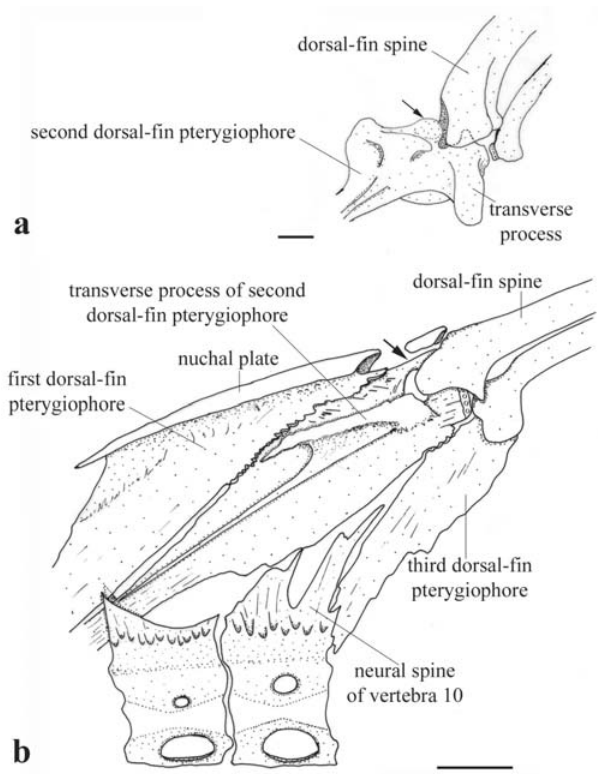
Fig. 45. Lateral view of portion of the dorsal-fin and associated elements (left side) of Pterygoplichthys sp. (modified from of Schaefer, 1987: fig. 17c) (a), and Pterosturisoma microps (MZUSP 79909, 75.9 mm SL) (b). Arrow points to condyle (a) and chain-like structure (b). Scale bar = 1